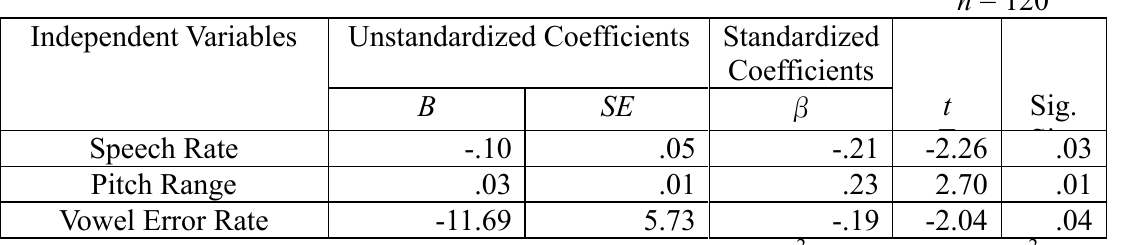
Stepwise Multiple Regression Analysis between Intelligibility Scores and Seven Speech Characteristics (Japanese